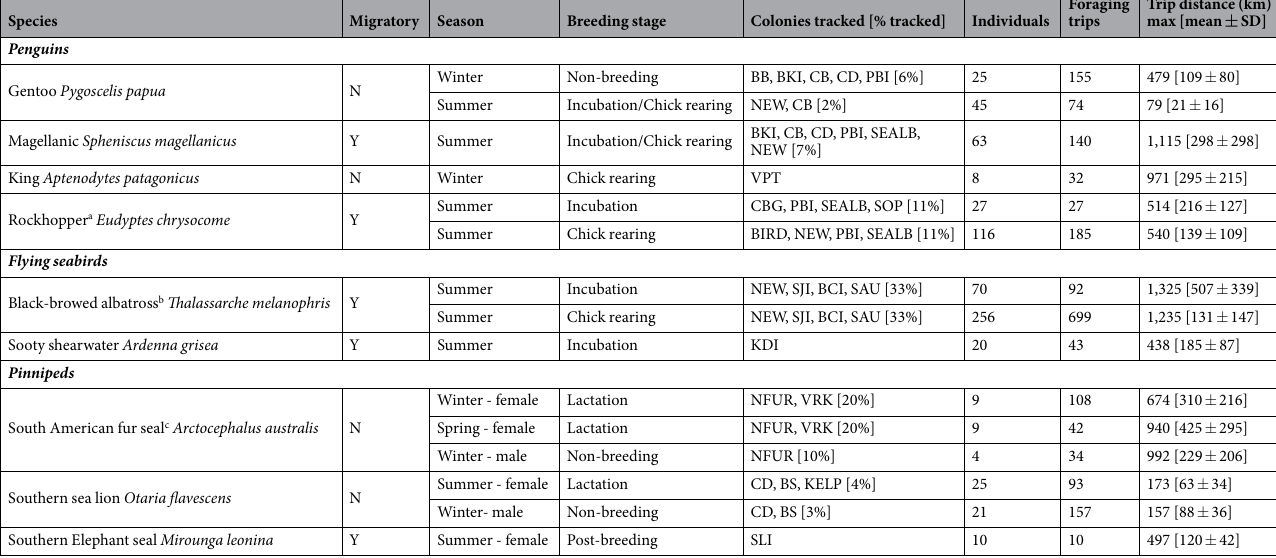
Table 1. Biotelemety and biologging data collated for nine marine predators breeding at the Falkland Islands. Data include 686 individuals and 1,891 foraging trips. a Total number of rockhopper penguins tracked was 137, but some birds were tracked over both incubation and chick rearing periods. b Total number of black-browed albatross tracked was 319, but some birds were tracked over both incubation and chick rearing periods. c Total number of female South American fur seals tracked was 9. Please see Supplementary Information Table S1 for data